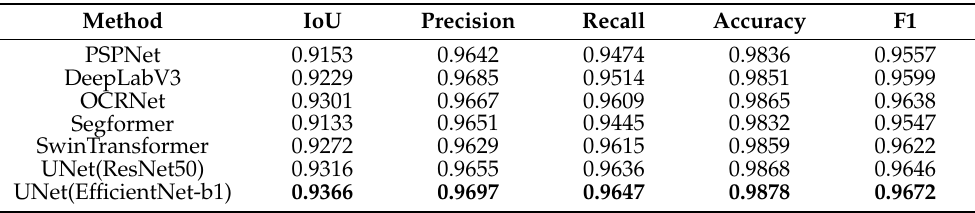
Table 3. Evaluation metrics of the results obtained by different semantic segmentation methods on the Wuhan University building change detection dataset.